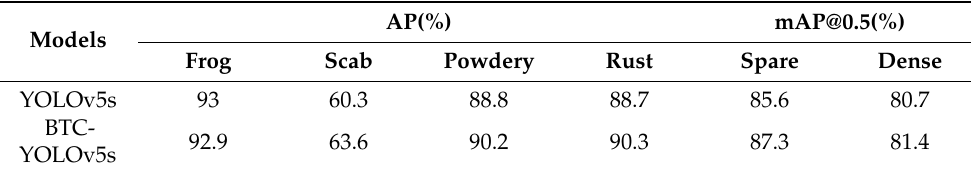
Table 3. Comparison of detection results of YOLOv5s and BTC-YOLOv5s. AP(%) mAP@0.5(%) Models Frog Scab Powdery Rust